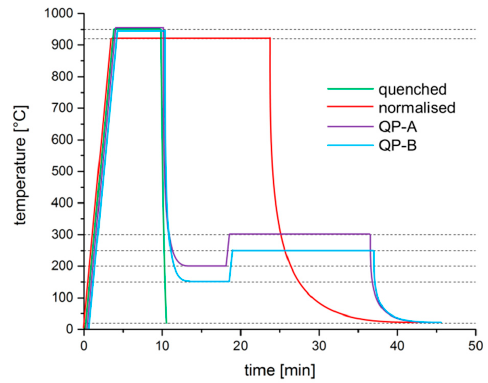
Figure 5. Thermal history sketch of the di ff erent heat treatments performed in this